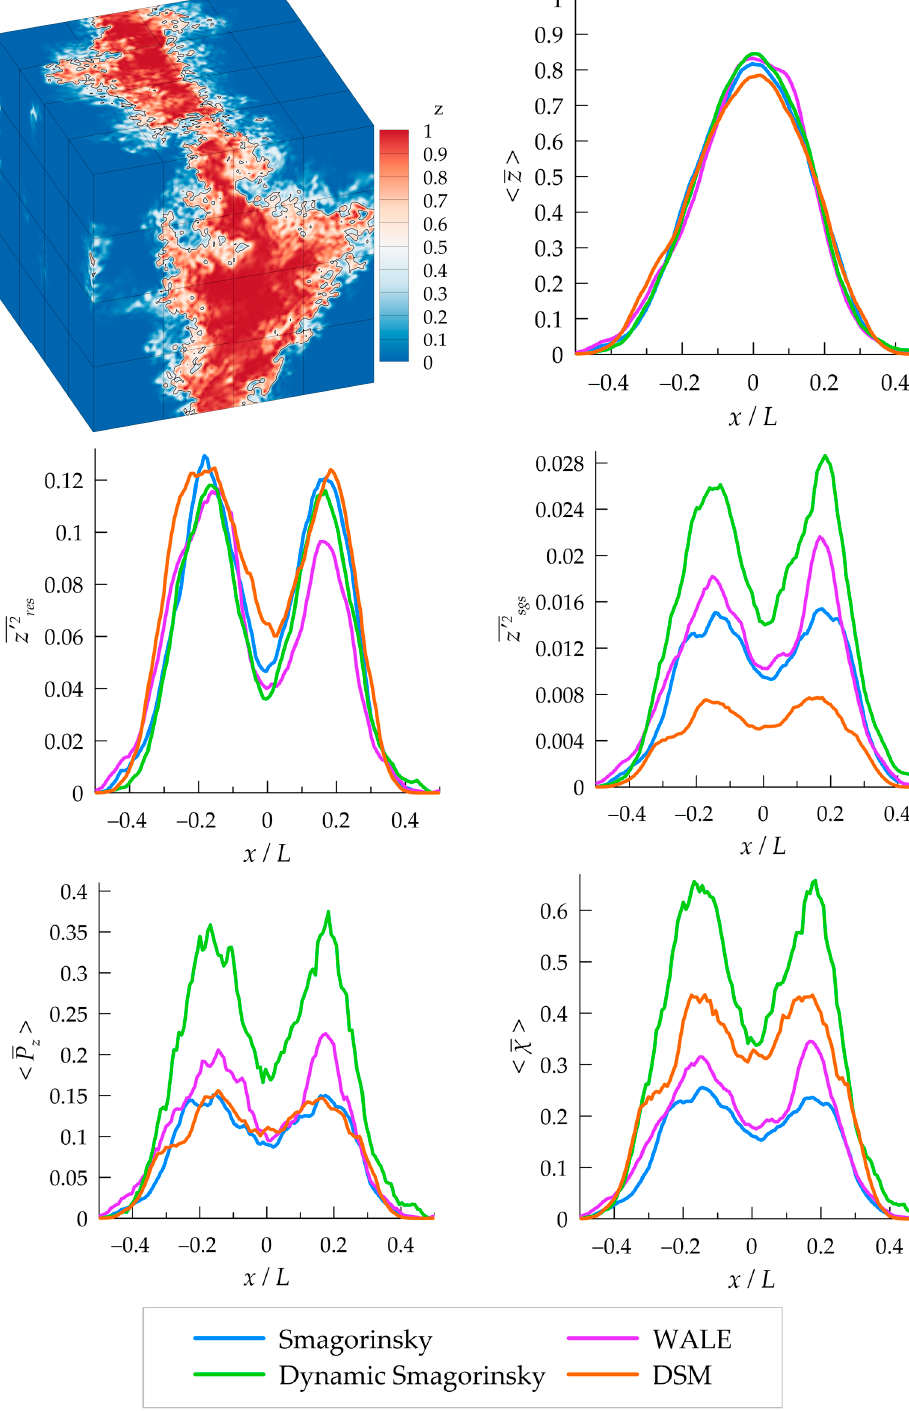
Figure 10. Time instance 𝑡 = 0.15𝑇 (cid:2868) . Designations as in Figure